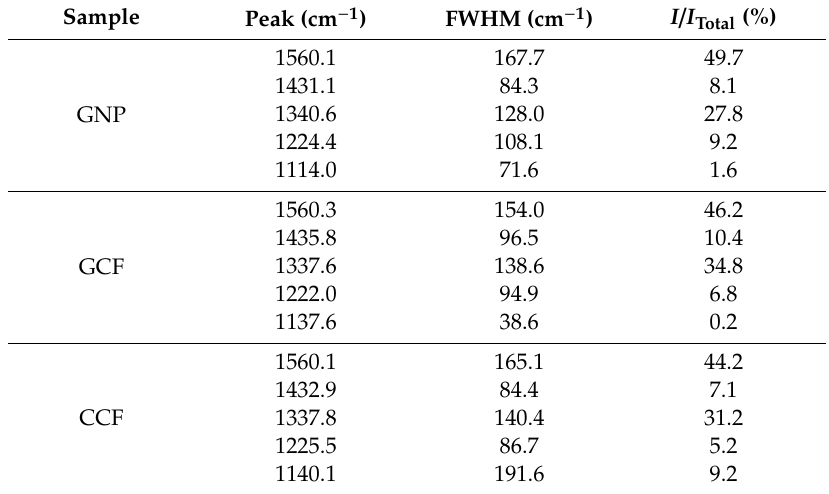
Table 1. Position, FWHM, and I / I Total of peaks after deconvolution of Raman